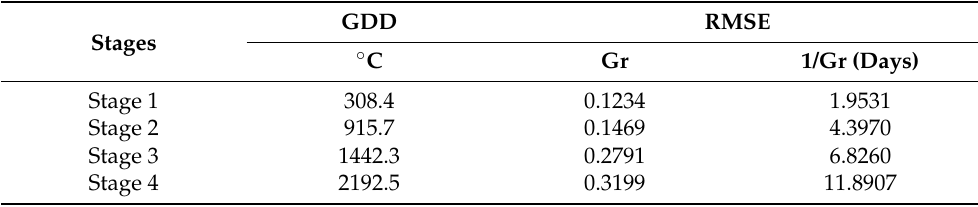
Figure 5. The relationship between accumulated GDD and Gr. Each data point represents the observed rice growth rate (Gr) data and its related cumulated GDD. The red dash-line is the least- squares regression line. Table 1. GDD in each specific key